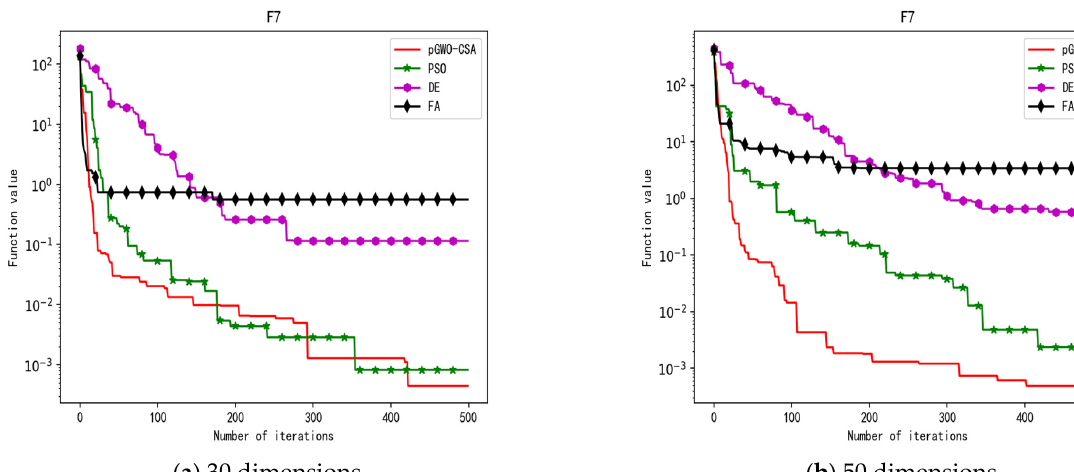
Figure 11. Convergence curve of test function F7.